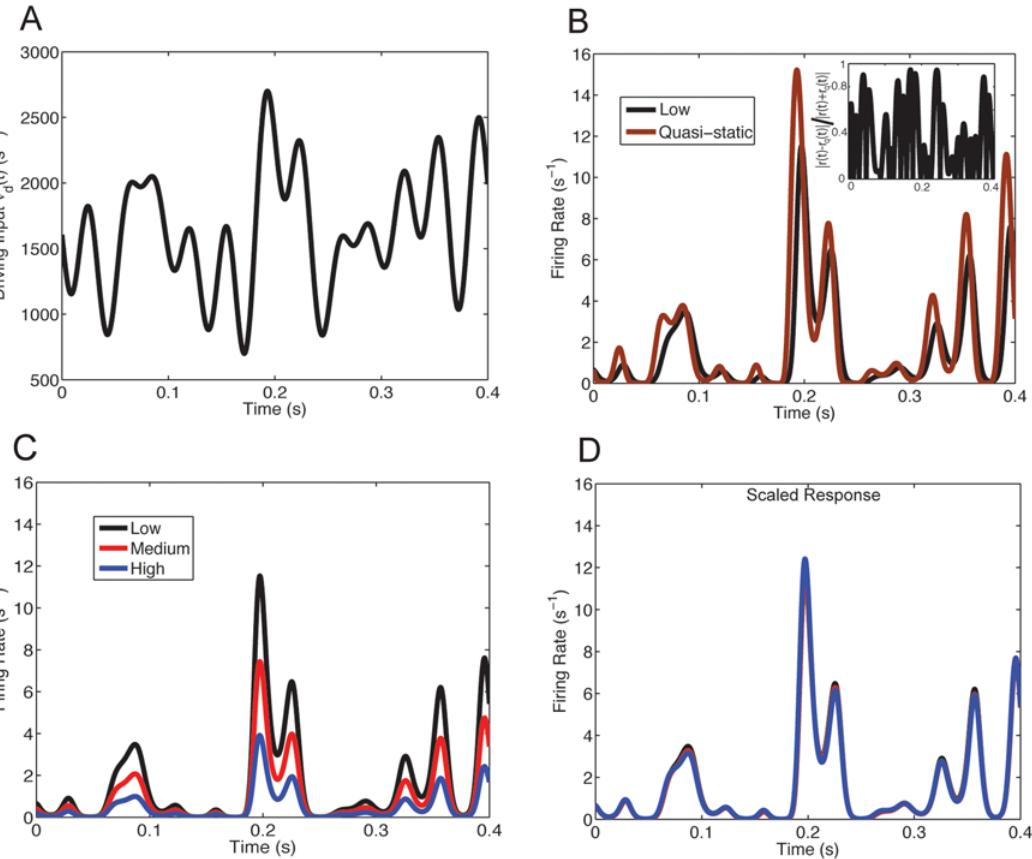
Figure 3. Gain modulation with temporally rich stimuli, and a refractory period. (A) The driving input n d t ð Þ ~ P sin 2 p f j t z w j (cid:1) (cid:2) for f j j ranging from {1, 10, 25, 30, 50, 60}s 2 1 and w j chosen randomly. (B) For the highly varying temporal driving input n d t ð Þ in (A) the output firing rate r t ð Þ for balanced background synaptic input low computed using the population density method does not match the quasi-static approximation r q t ð Þ ~ r eq n d t ð Þð Þ (brown curve). Inset: plot of r t ð Þ { r q t ð Þ (cid:8) (cid:8) (cid:8) (cid:8)(cid:9) r t ð Þ z r q t ð Þ (cid:8) (cid:8) (cid:8) (cid:8) shows the absolute value of the difference of r q t ð Þ and the actual response r t ð Þ divided by the arithmetic mean can differ greatly. (C) The firing rate response to driving input in (A) with different balanced background levels. ~ 1 : 72 and c eq ~ 3 : 2 ). used in Figure 2C are used here ( c eq (D) The responses scaled with the same coefficients c eq j 2 3